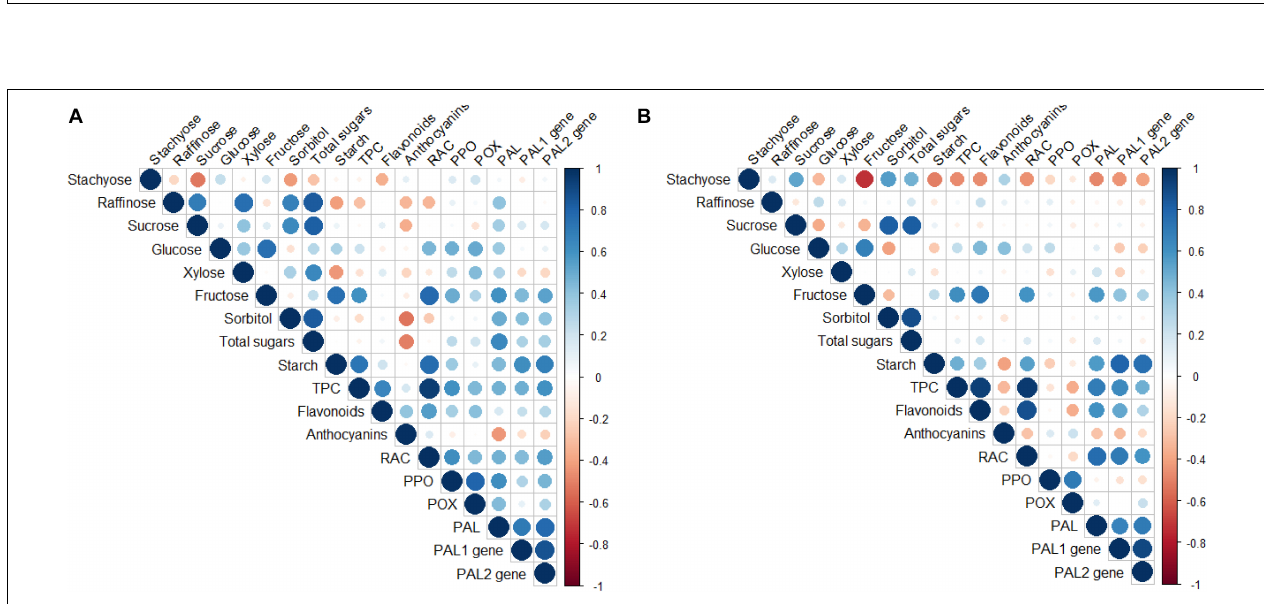
Frontiers in Plant Science |